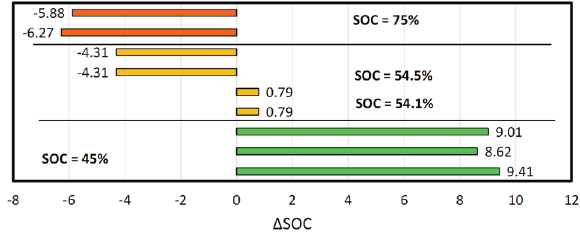
Fig. 3. The change of SoC value during the entire